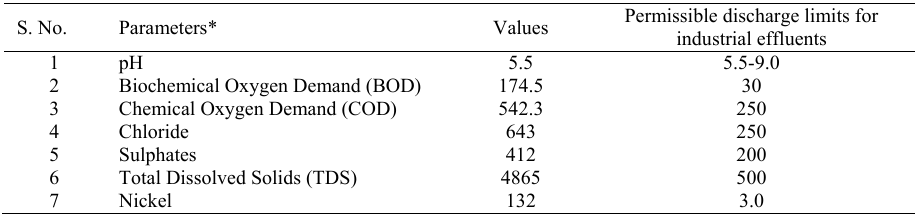
Table 2: Physico-chemical characteristics of nickel electroplating industry wastewater S. No.